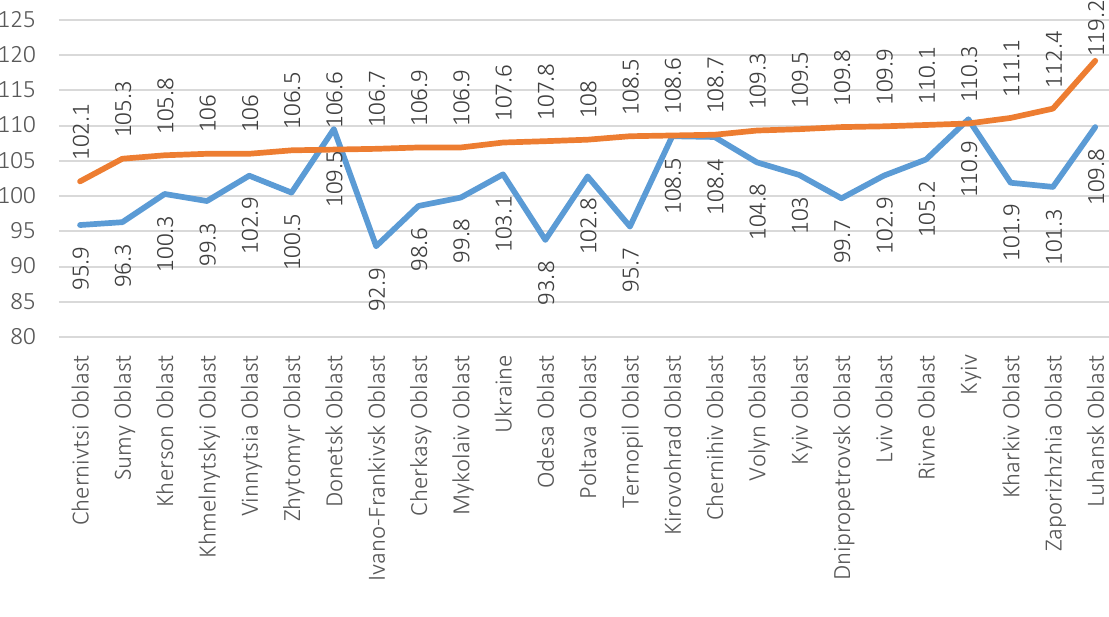
Figure 7. Local budgets’ single tax revenues across regions,